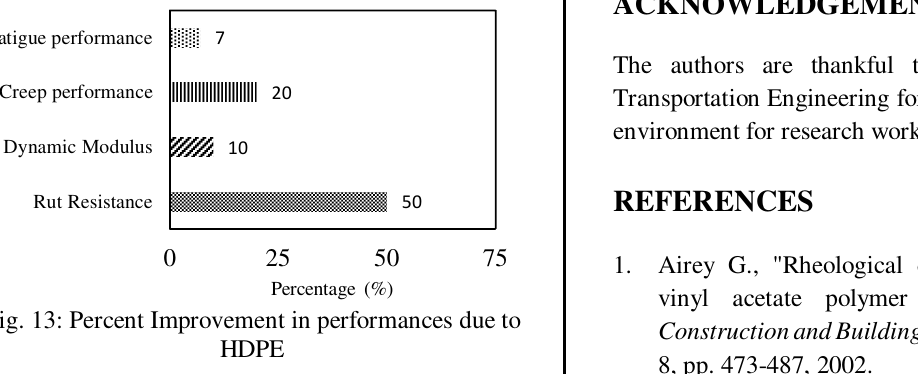
Fig. 13: Percent Improvement in performances due